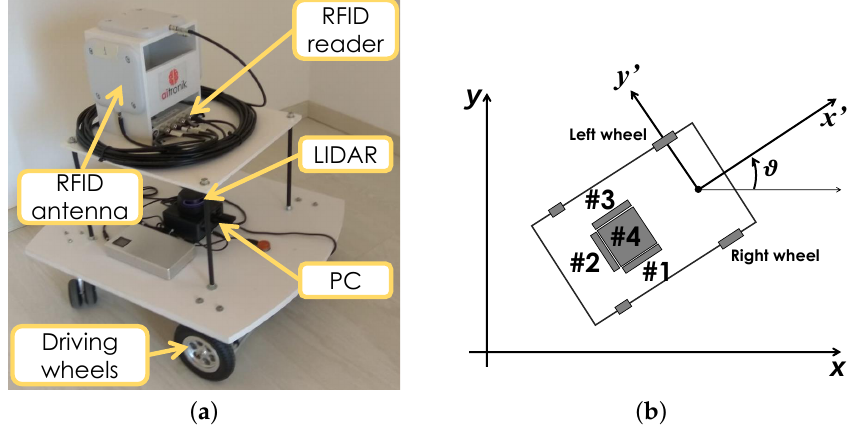
Figure 2. ( a ) Robot used for the experimental campaign with its different components. ( b ) Schematic representation of the robot (top view). The robot antennas are denoted with the symbols #1, #2, #3, and